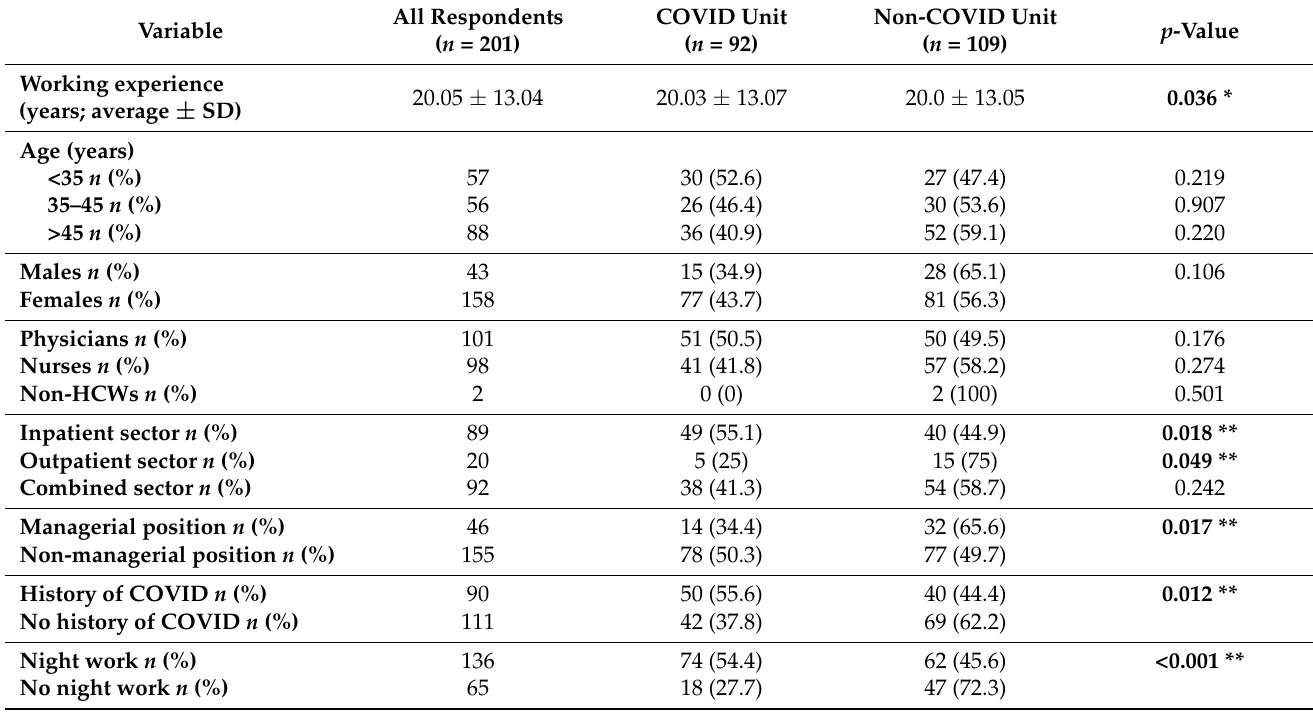
Table 2. Demographic characteristics of study population ( n =